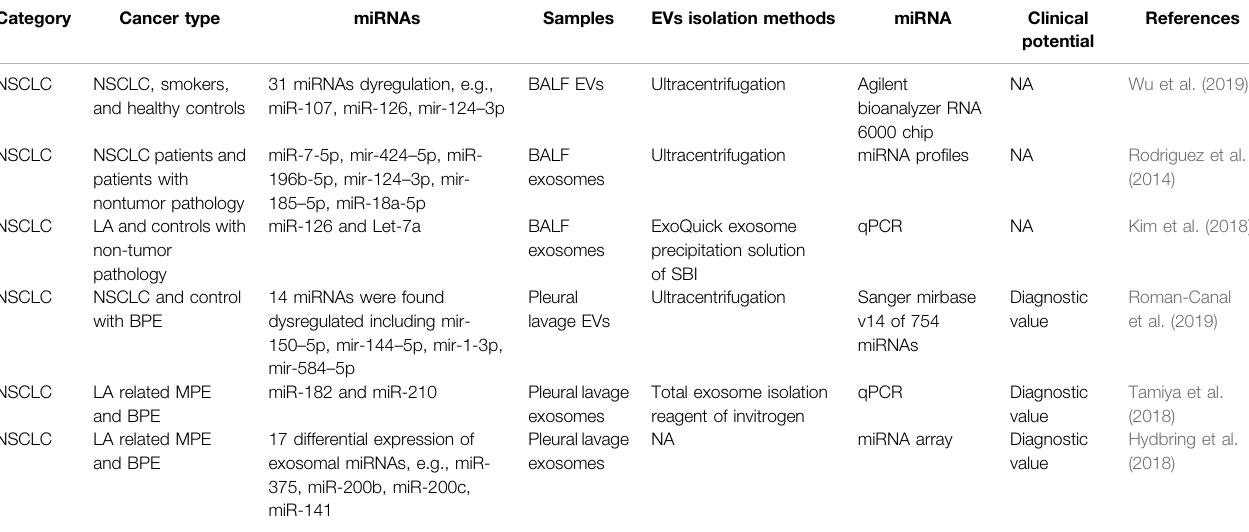
TABLE 3 | Lung speci fi c liquids: BALF and pleural